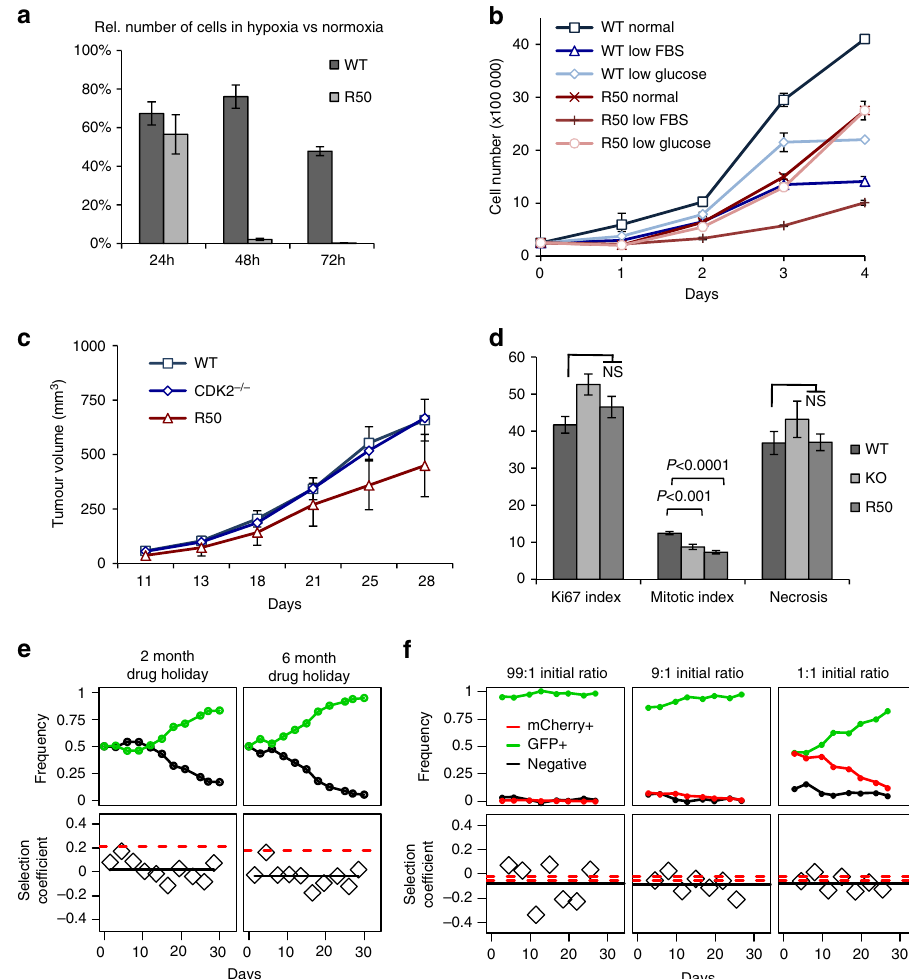
Fig. 3 CDKi-resistant cells have lower proliferative fi tness in vitro and in vivo. a WT and R50 cells were grown in 1% O 2 . Percentage of viable cells (relative to cells cultured in 21% O 2 ) was quanti fi ed after 24 h, 48 h and 72 h (mean ± SD of two independent experiments). b WT or R50 cells were grown in low serum (1%) or low glucose (1 g/L) and their number was analysed every 24 h (mean ± SEM of 2 independent experiments). c Nude mice were injected subcutaneously with WT, CKD2 − / − , or R50 cells, and tumour volume was measured at 3-day intervals ( n = 8 mice per condition; mean ± SD). d Immunohistochemistry analysis of mitotic index, Ki67 expression and necrosis (Caspase 3a) in xenograft tumour samples from c (represented as % of cells, mean ± SEM; t -test, ns, not signi fi cant). e , f Frequency dynamics (top row) and selection coef fi cients for competition assays, compared to predictions from growth rates (bottom row). In the bottom row, each point corresponds to a selection coef fi cient calculated from a competition assay (i.e., a period between consecutive points in the top row). Solid lines are means. Red dashed lines indicate predictions based on the growth rates of each cell type in isolation (Supplementary Methods). A single prediction is shown whenever growth curves were measured at the same time as competitions were conducted; otherwise pairs of lines show maximum and minimum predictions based on non-contemporaneous growth curves. Results are shown for competitions between GFP+CDKi-sensitive cells and drug-holiday GFP- CDKi-resistant (R50) cells ( e ), and for competitions between GFP+CDKi-sensitive cells and mCherry+R50 cells with different initial ratios